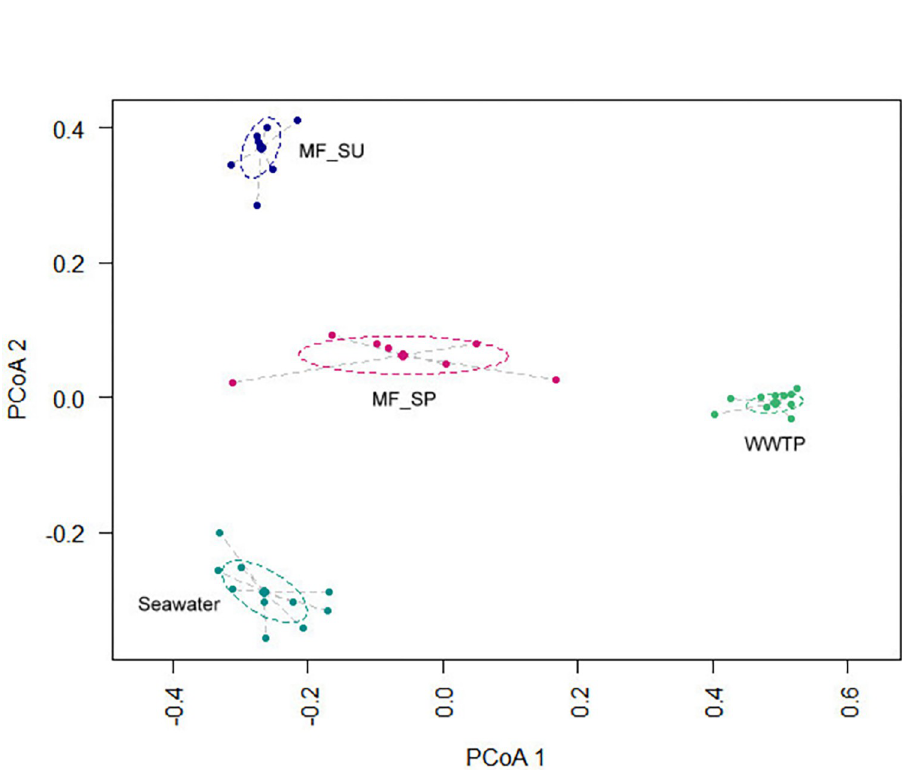
Fig 3. Principal coordinate analysis (PCoA) plot showing dissimilarities among the bacterial community composition attached to microfibers from summer (MF_SU) and spring (MF_SP) seasons, the free-living bacteria from the Seawater and from the Haliotis Waste Water Treatment Plant (WWTP). Samples were grouped based on Jaccard distance matrix.